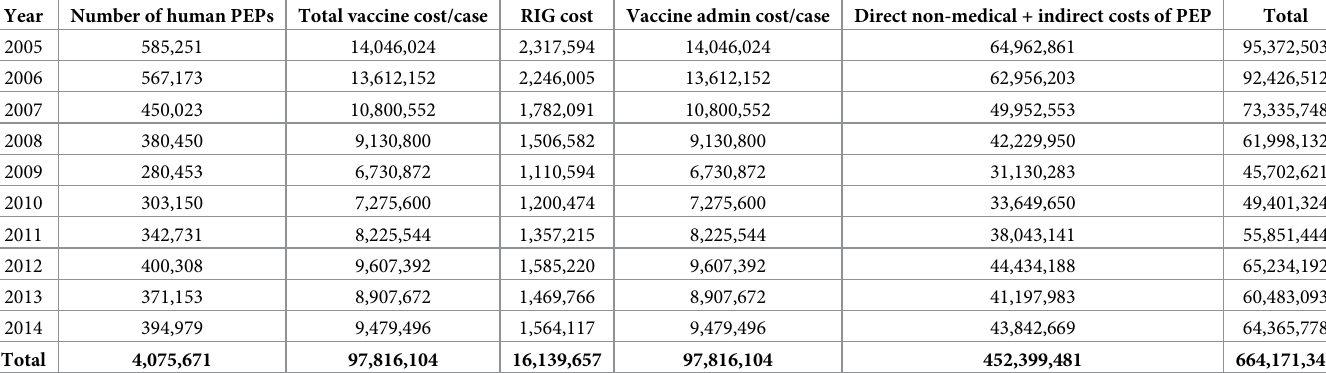
Table 10. Costs (in 2017 USD) of canine rabies prevention in humans in Viet Nam from 2005 through 2014.